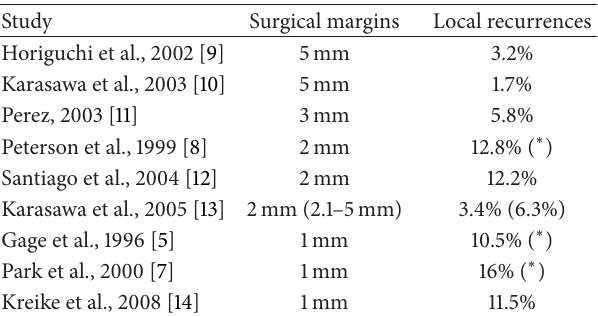
Table 2: Most common features associated with positive surgical margins